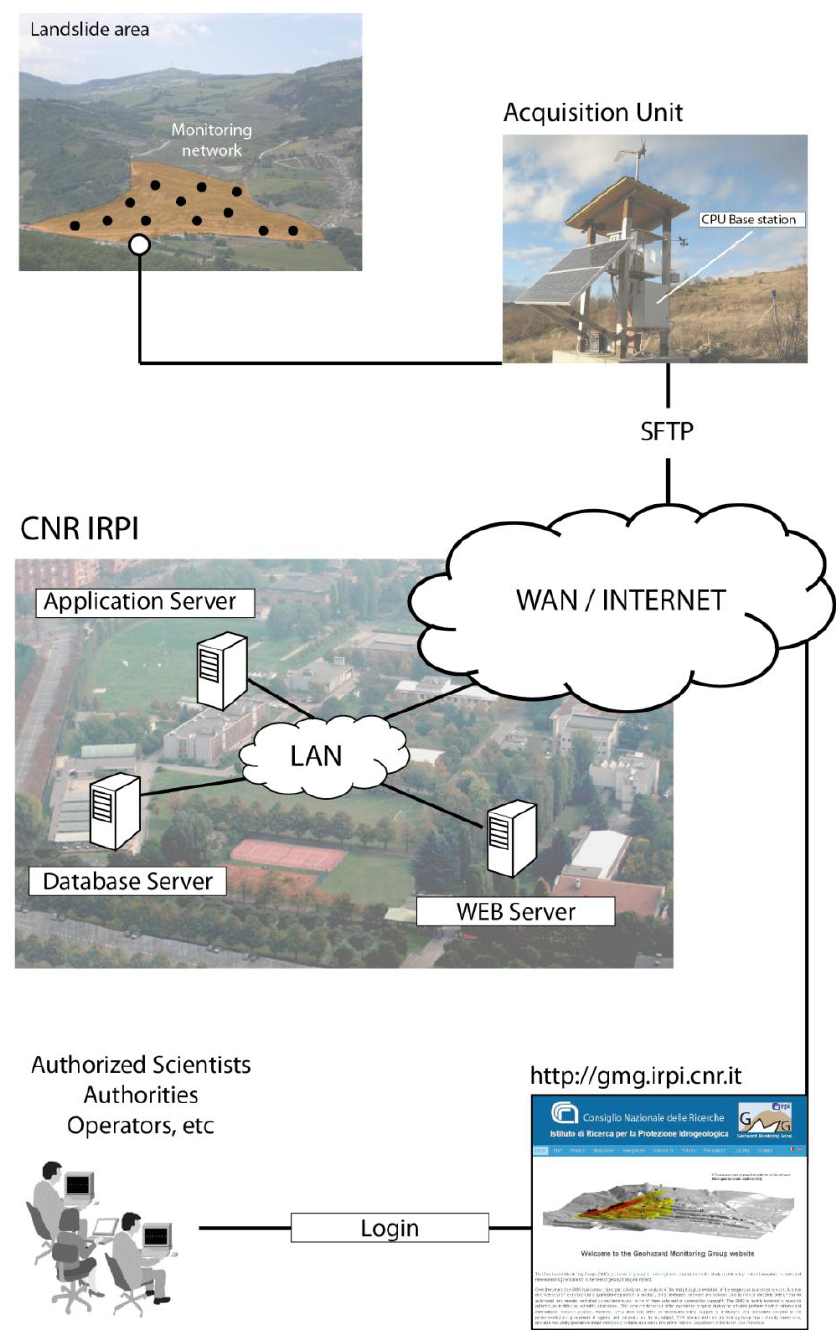
Figure 2. Rationale of the ADVICE system as applied for displacement monitoring via RTS in a landslide